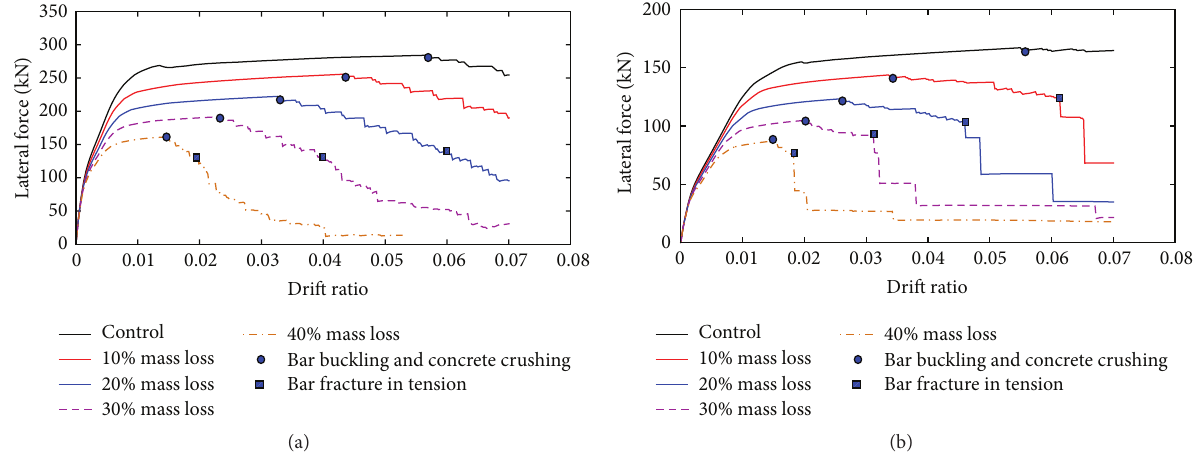
Figure 12: Pushover analyses considering corrosion induced damage in reinforcing steel, cracked cover concrete, and confined concrete: (a) Lehman’s column 415; (b) Moyer and Kowalsky’s column